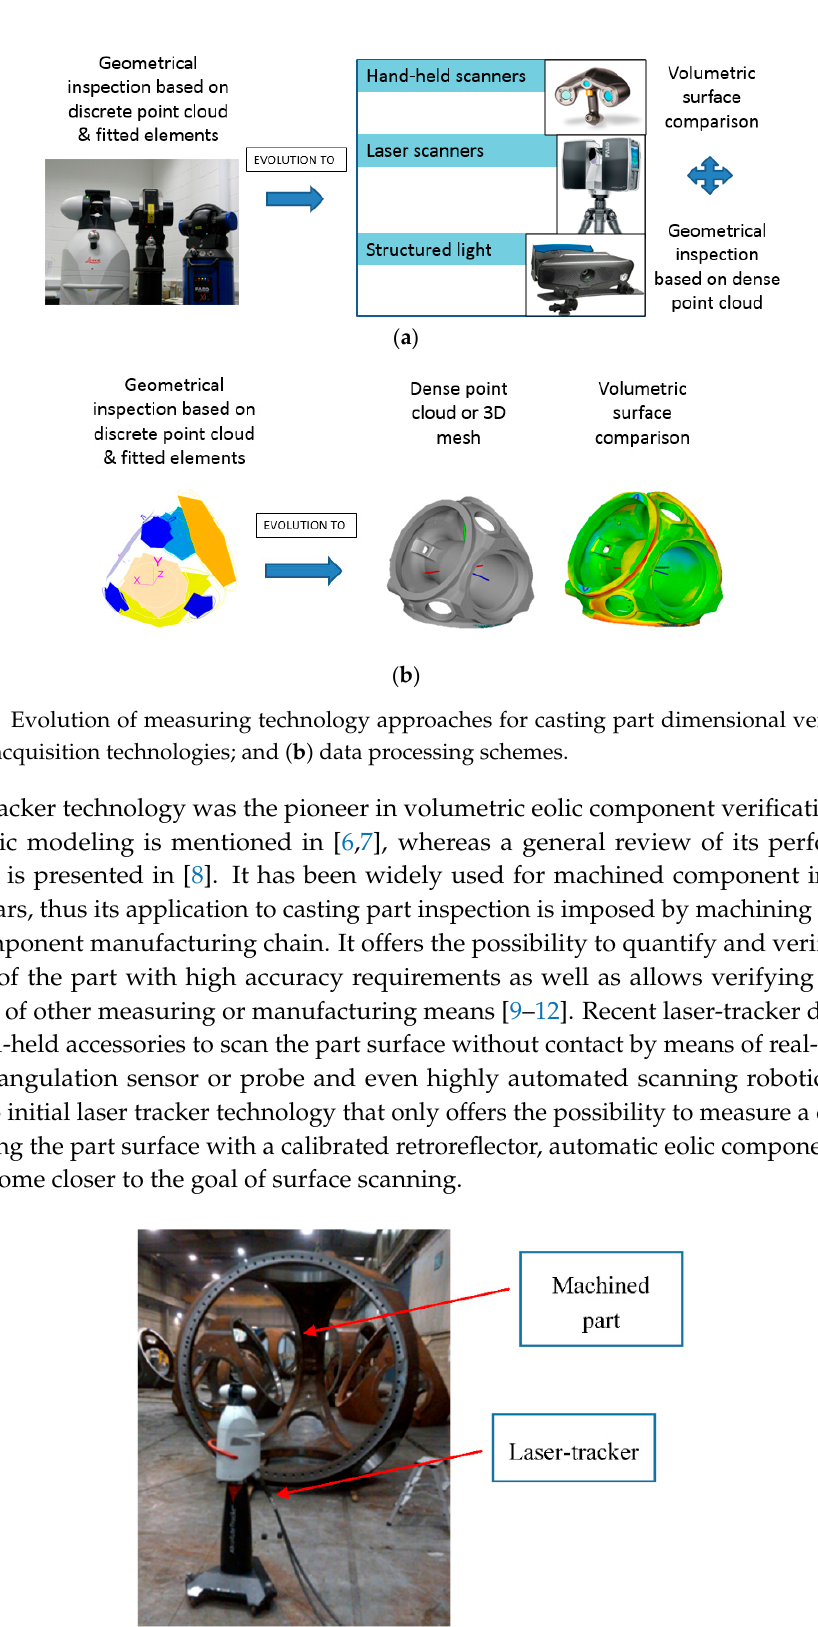
Figure 2. Laser-tracker technology for machined part dimensional inspection.